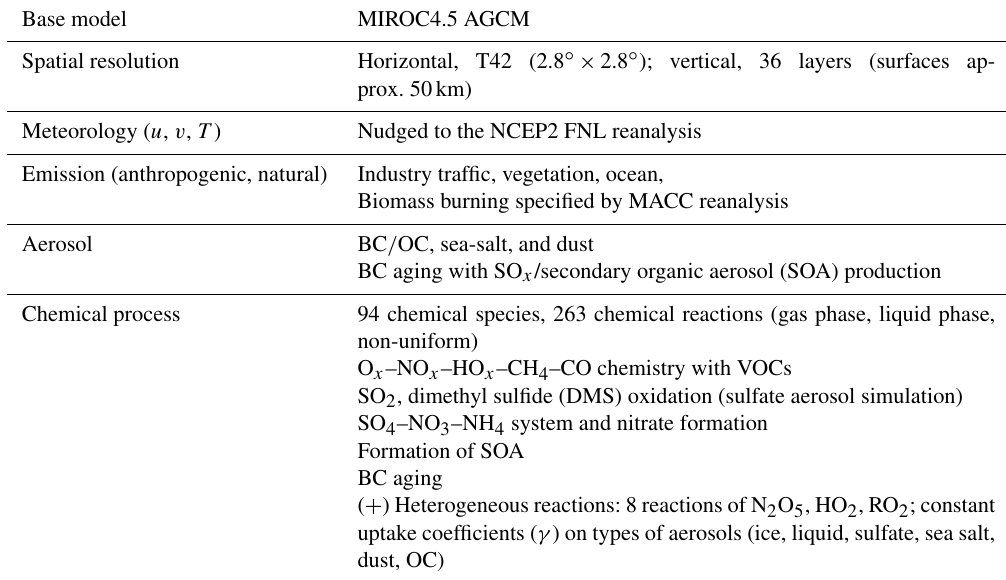
Table 1. Computation packages in the chemistry–climate model CHASER.